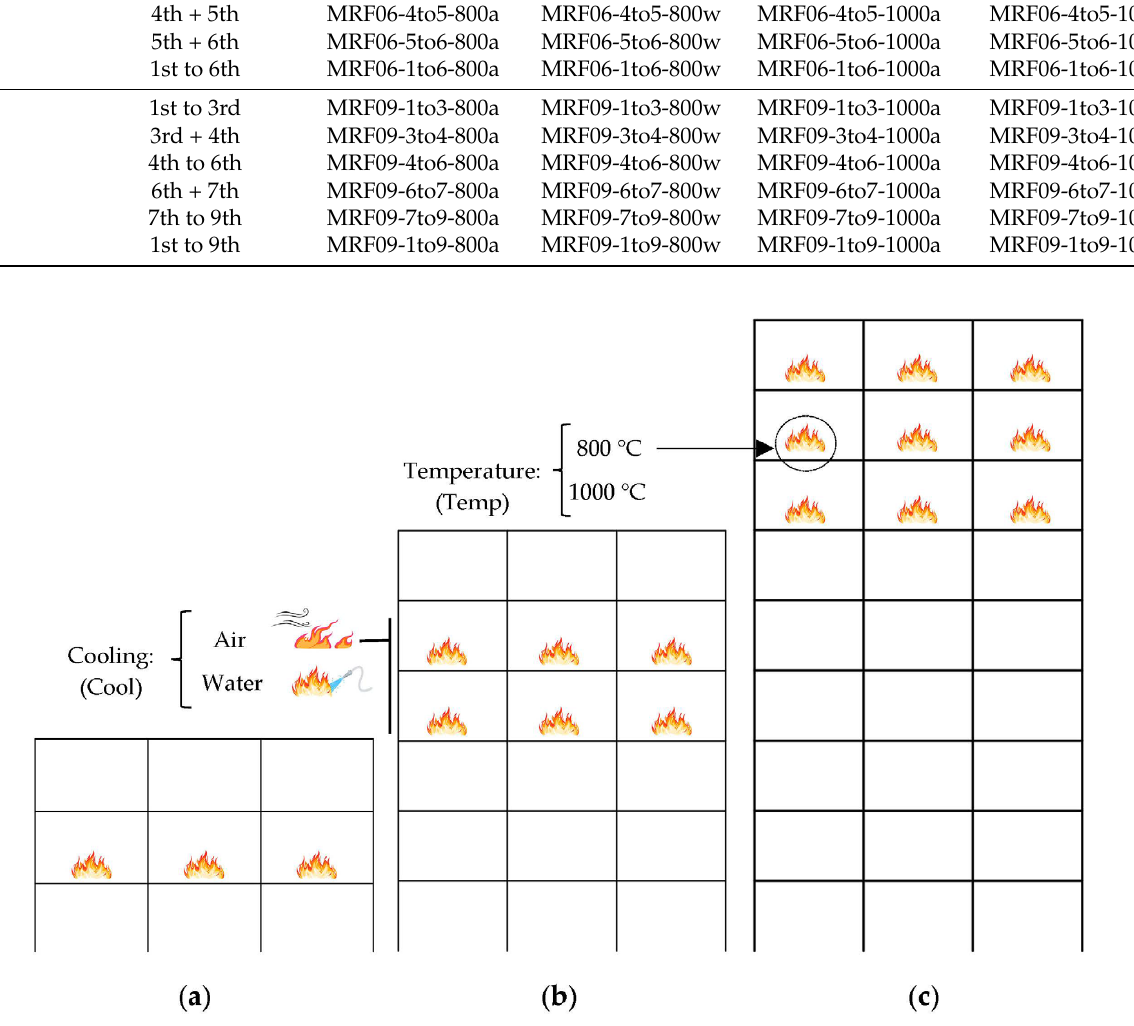
Figure 4. Scheme of the fire scenarios; ( a ) [MRF03-2-Temp-Cool]; ( b ) [MRF06-4to5-Temp-Cool]; ( c ) [MRF09-7to9-Temp-Cool].